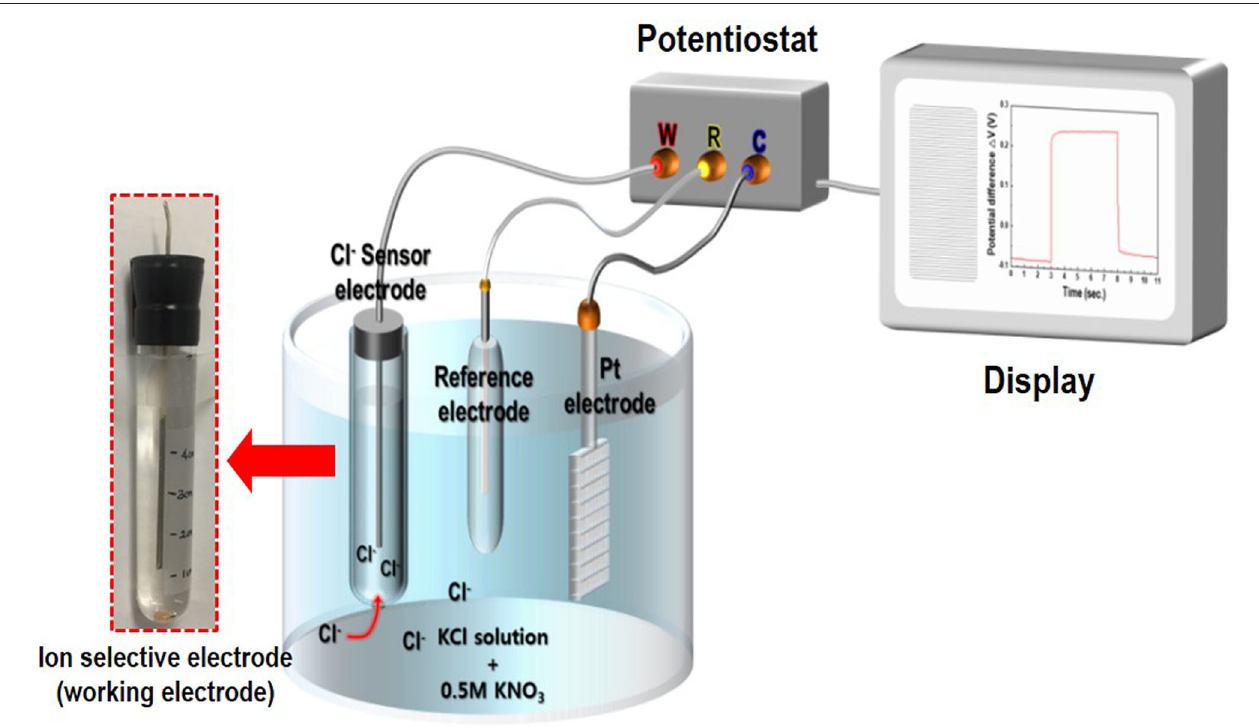
FIGURE 1 | Schematic of the chloride ion sensor comprising an Ag/AgCl reference electrode, Pt-counter electrode, and Ag/AgCl ion-selective electrode (Ag/AgCl ISE) based on a gel-type internal electrolyte and diatomite ceramic